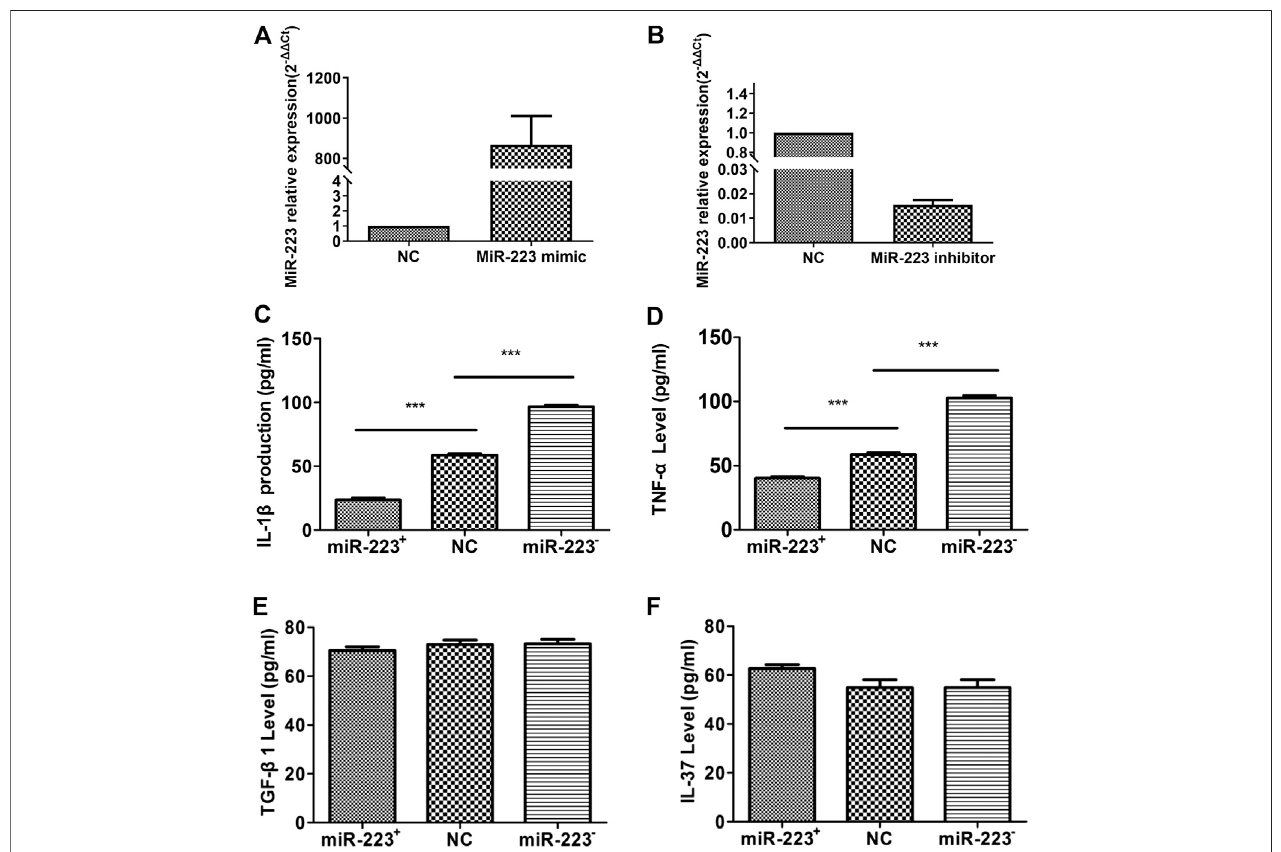
FIGURE3| EffectofmiR-223onthesecretionofcytokinesfromRAW264.7murinemacrophagestreatedwithMSU. (A) TransfectionofmiR-223 mimics(100 nM) for 24 h increased miR-223 expression approximately 1000-fold in RAW264.7 macrophages. (B) Transfection of miR-223 inhibitors (100 nM) for 24 h signi fi cantly decreased miR-223 expression by at least 80% in RAW264.7 macrophages. (C, D) Increased miR-223 abundance suppressed production of IL-1 β and TNF- α ( n (cid:2) 5, t (cid:2) − 18.67, − 11.214), while decreased miR-223 abundance enhanced IL-1 β and TNF- α production compared to that of the NC cells ( n (cid:2) 5, t (cid:2) 24.45,19.07), *** p < 0.001. (E, F) Secretion of TGF- β 1 and IL-37 was not affected by increased ( n (cid:2) 5, t (cid:2) 1.041, 0.001; p > 0.05, respectively) or decreased ( n (cid:2) 5, t (cid:2) 0.146, 2.126; p > 0.05, respectively) expression of miR-223 in RAW264.7 cells in comparison with NC cells. The cells were transfected with 100 nM of a miR-223 mimic or miR-223 inhibitor for 24 h, then stimulated with 200 μ g/ml MSU for 12 h, and fi nally evaluated of TNFa, IL-1, TGF- β 1 and IL-37 in supernatant culture.